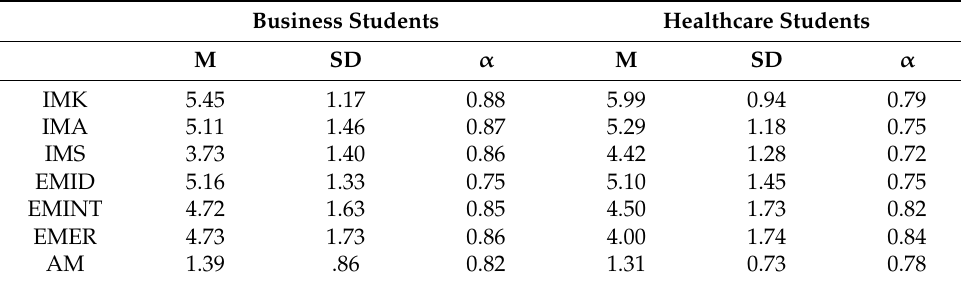
Table 4. Levels of each type of motivation in business students (n = 61) and healthcare students (n = 59).